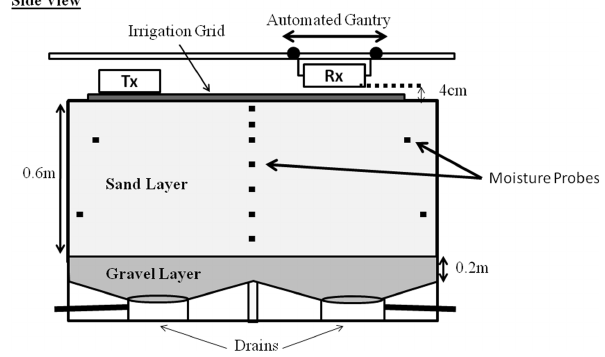
Fig. 1. Experimental setup for lab-scale infiltration